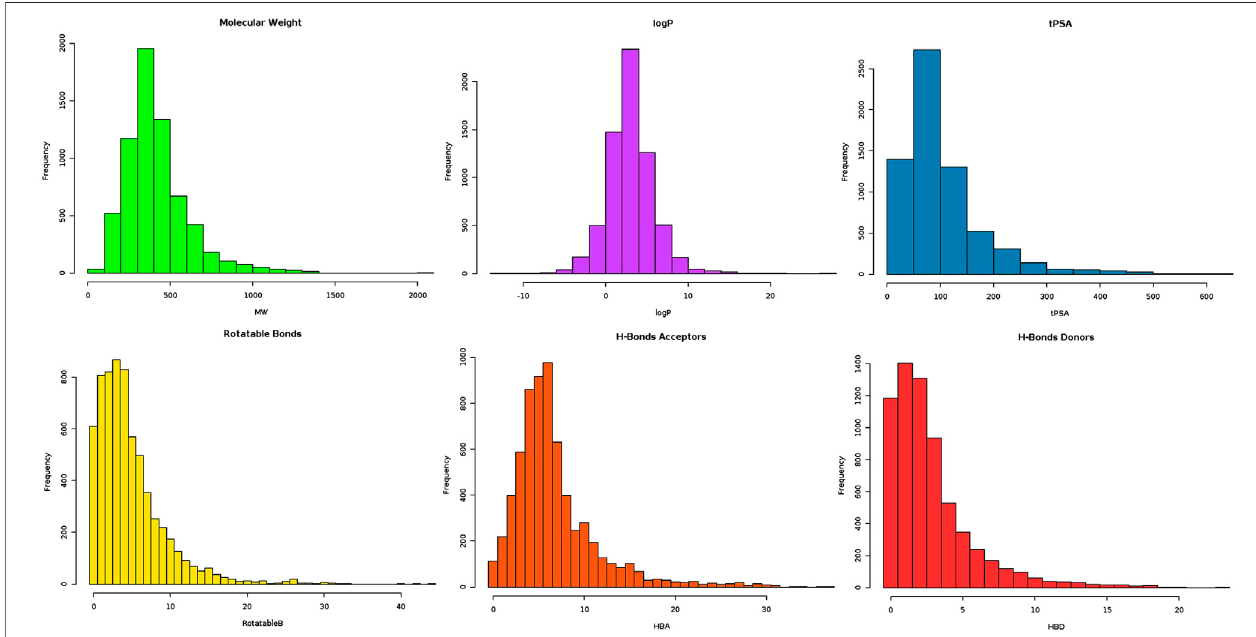
FIGURE 1 | Graphical illustration of FAF-Drugs4 server output, highlighting distribution of lead-like compounds on different parameters (bars of different colors are associated with different parameter results).